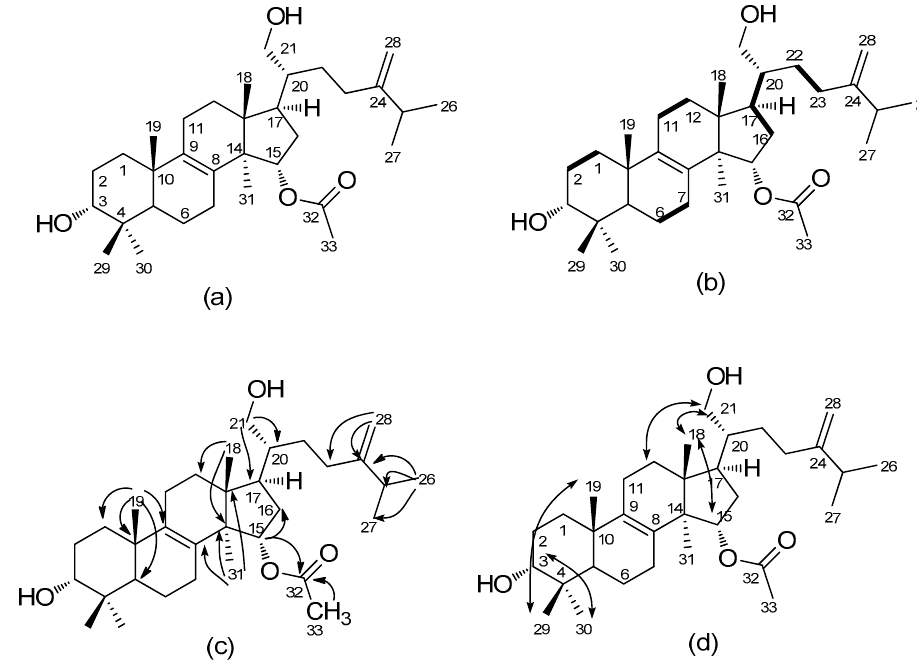
Figure1. StructureofcamphoratinK( 1 )( a )anditskeyCOSY( b ), HMBC( c ), andNOESY( d Figure 1. Structure of camphoratin K ( 1 ) ( a ) and its key COSY ( b ), HMBC ( c ), and NOESY ( d ) correlations.